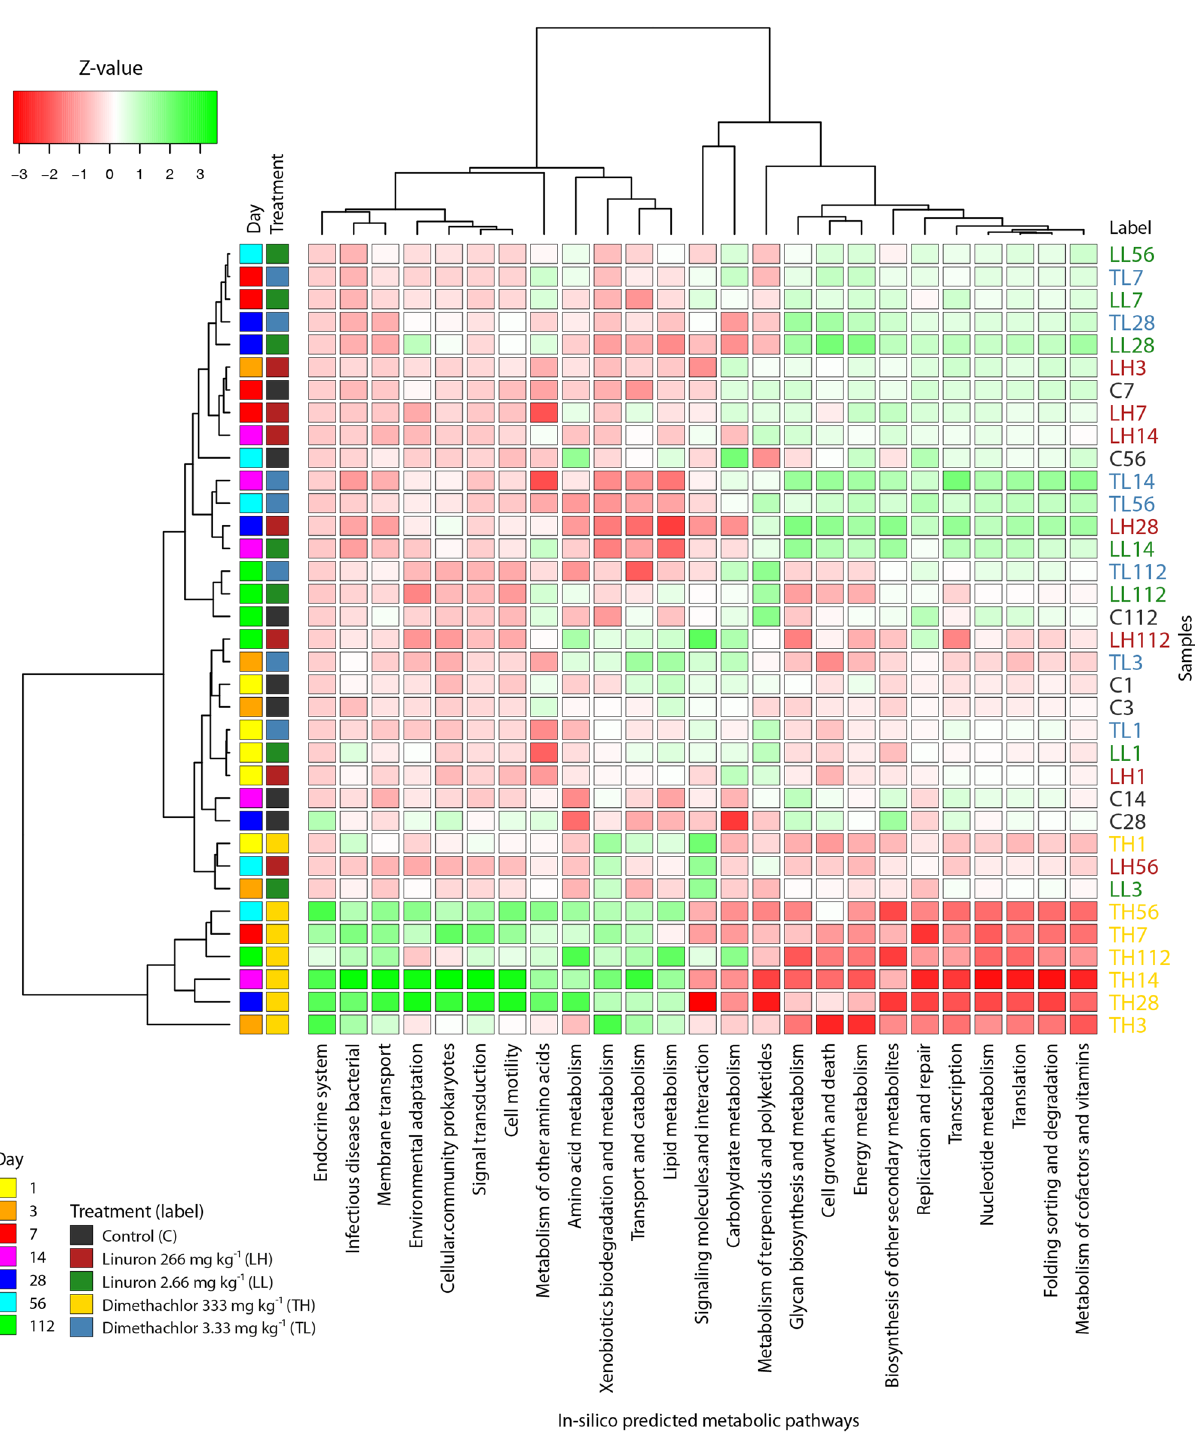
Figure 6. Heatmap of KEGG annotated (level 2) metabolic pathways predicted by PICRUSt2 in soil samples treated by herbicides linuron and dimethachlor. Relative expression values are column normalized and